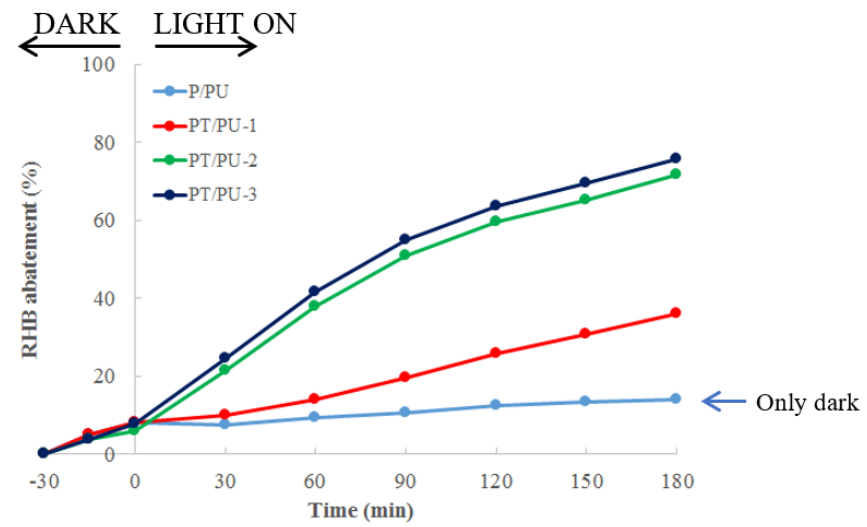
Figure 3. Percentage of RHB abatement tests using P/PU (only in the dark), PT/PU-1, PT/PU-2 and PT/PU-3 (30 min in the dark and 180 min under solar light irradiation).